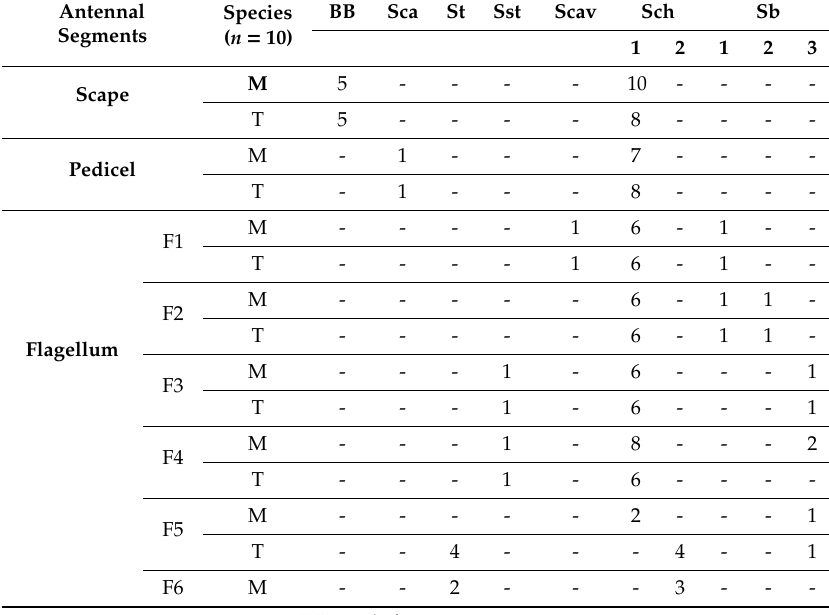
Table 2. Number and distribution of antennal sensilla of Megalurothrips usitatus and Thrips